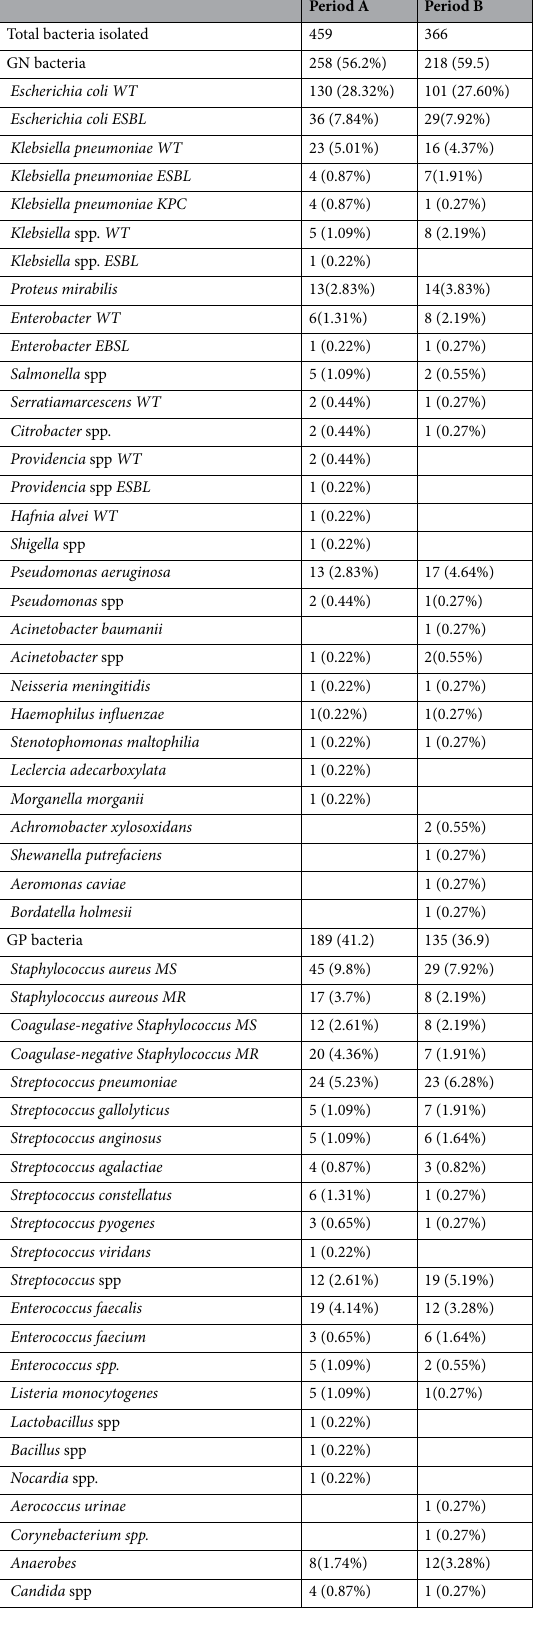
Table 2. Bacteria isolated in blood cultures. GP Gram positive, GN Gram negative, WT wild type, ESBL extended spectrum beta-lactamase, MS methicillin sensitive, MR methicillin